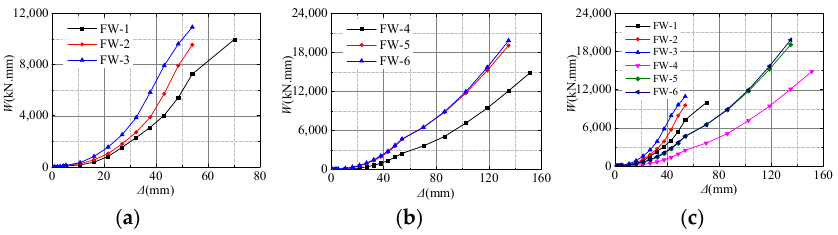
Figure 16. Comparisons of cumulative energy consumption curves: ( a ) Specimens with rigid brac- ings; ( b ) Specimens with flexible bracings; ( c ) Comparison of all specimens.